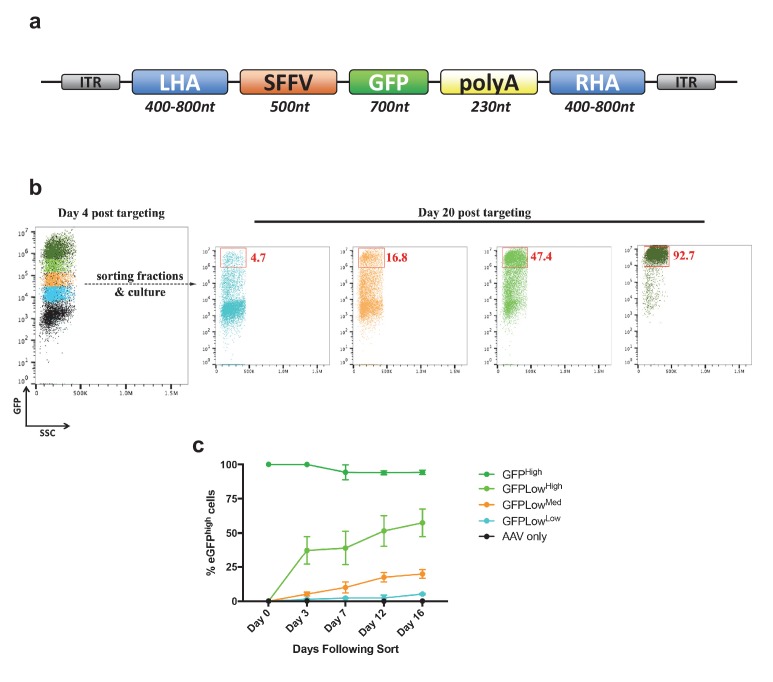
Analysis of cell fractions with different fluorescence intensity.(a) Schematic showing the general layout of the AAV6 donors employed. ITR: inverted terminal repeat; SFFV promoter: spleen focus forming virus promoter; GFP: green fluorescent protein; polyA: bovine growth hormone polyadenylation signal; RHA: right homology arm. Approximate sizes are shown below each component. (b) Cells were targeted at the HBB locus by electroporation of Cas9 RNP followed by transduction of a homologous rAAV6 donor carrying a GFP expression cassette. At 4 days post electroporation and transduction, cells with different GFP intensities (GFPhigh, GFPLowHigh, GFPLowMed, GFPLowLow) were FACS-sorted and cultured for an additional 16 days. At day 20 post targeting, cells were analyzed for GFP expression by flow cytometry and the red gates show the GFPhigh population at this time point. (c) The cells from b) were analyzed at different time points after sorting, and data points show the percentage of cells within the GFPhigh gate for the different populations as well as a population receiving only the rAAV6 donor and not Cas9 RNP.